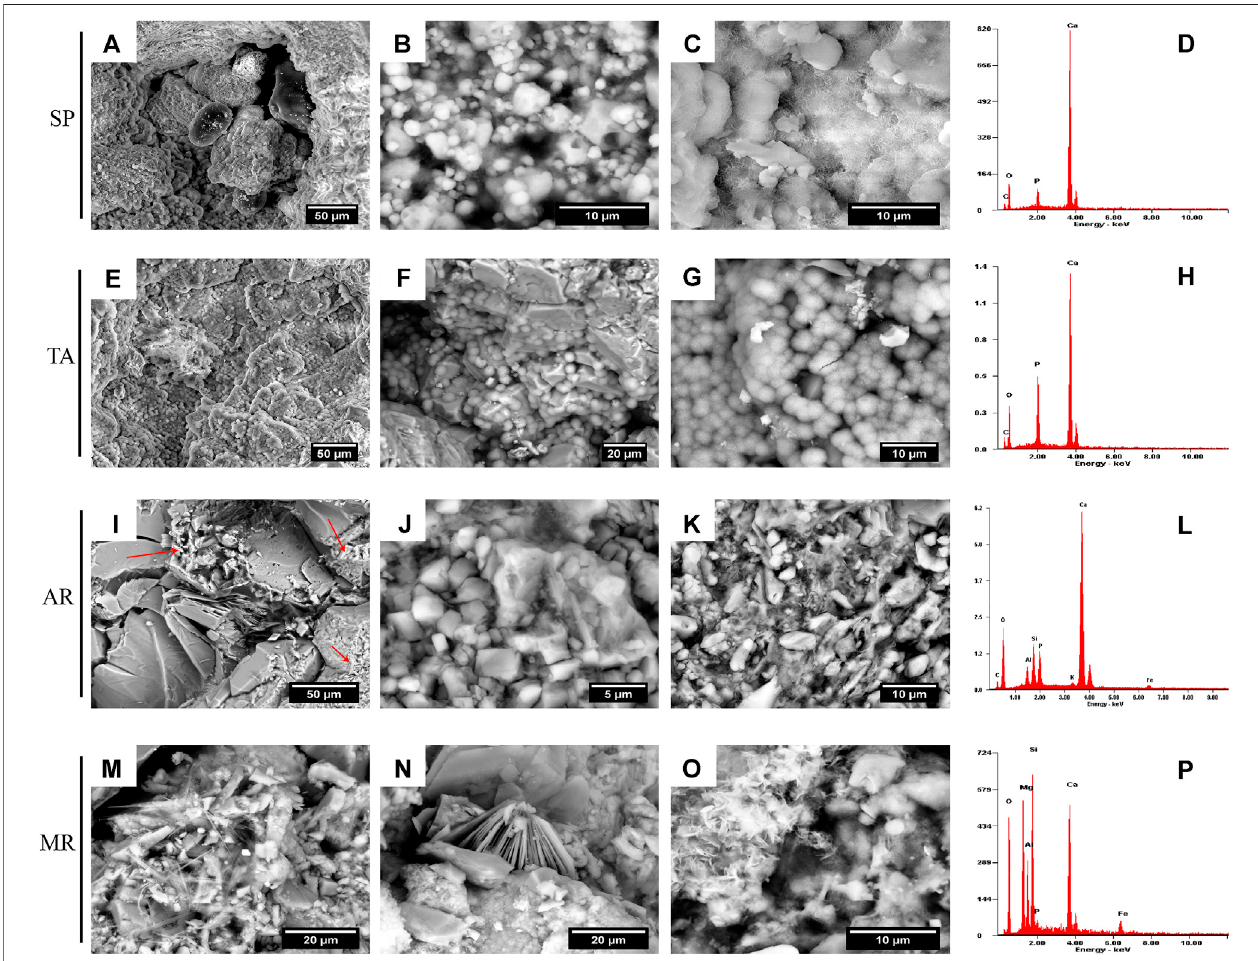
FIGURE3| ESEMmicrophotographsofthedifferenthabitsoftheHAPcrystalsinthesamplesofCalcarenitadeSantaPudia(SP, A – C ),Yellowtravertine(TA, E – G ), Arenisca Ronda (AR, I – K ) and Molinaza Roja (MR, M – O ). The EDX microanalyses that corroborate the presence of HAP are shown in images (D, H, L, and P) .